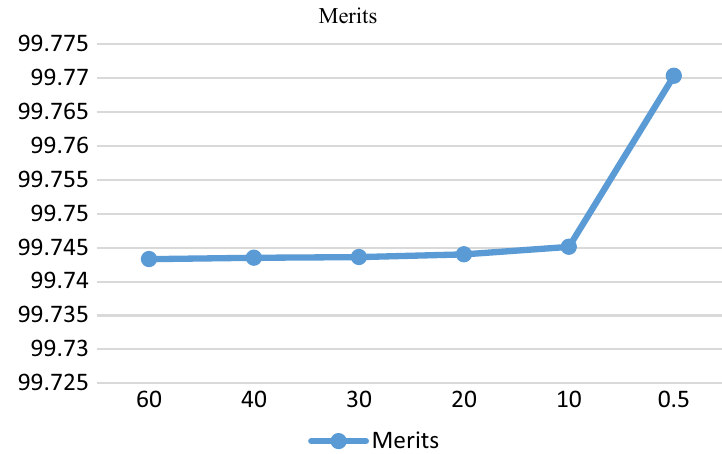
Fig. 9 Graph of the change of the two variables P and merit on the CICIDS dataset